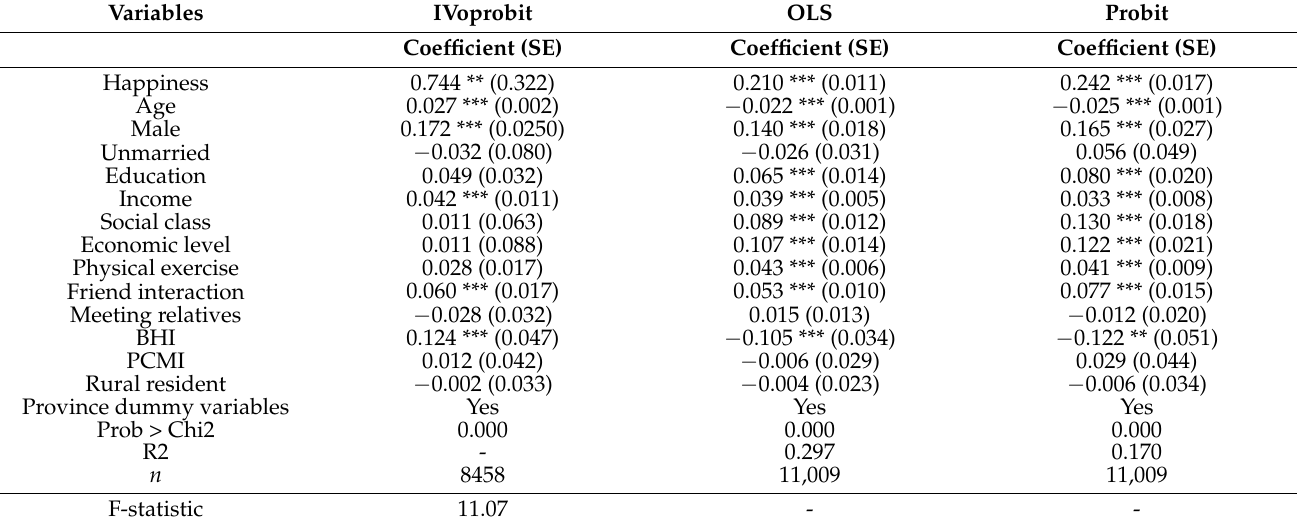
Table 7. Results of the robustness check.